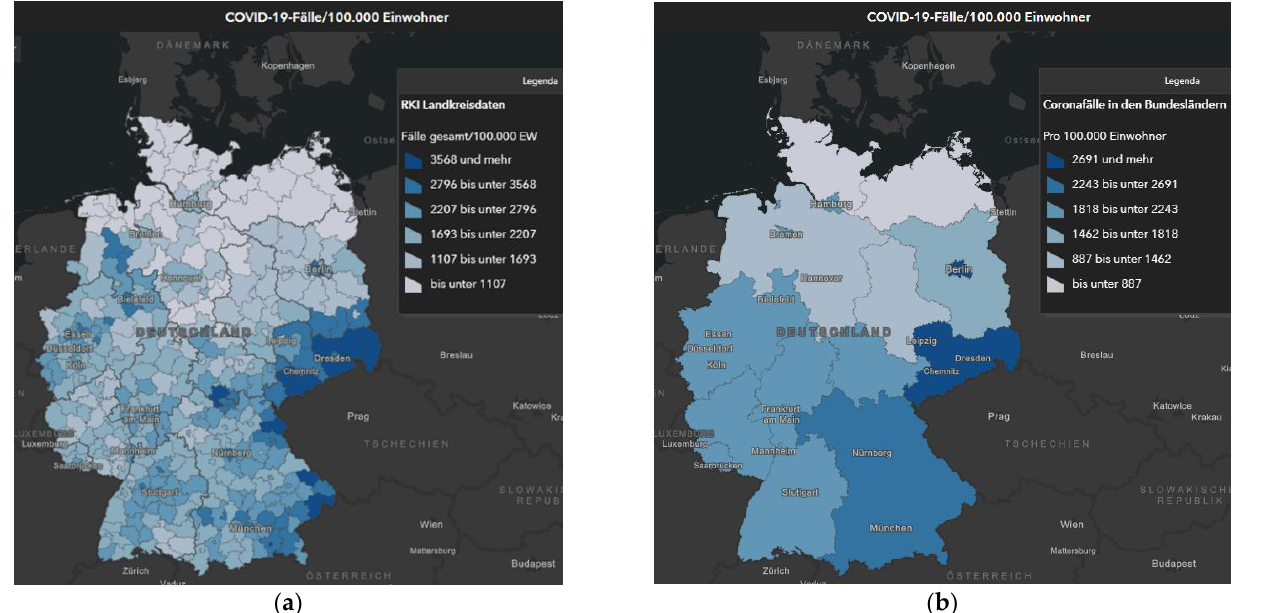
Figure 8 Visualization at NUTS 3 level of a major local COVID-19 outbreak in Germany, June 2020. 2